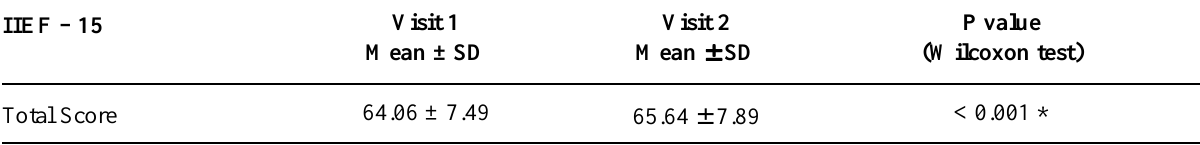
Table 6 – Total score of the IIEF applied on visits 1 and 2 (n = 64).